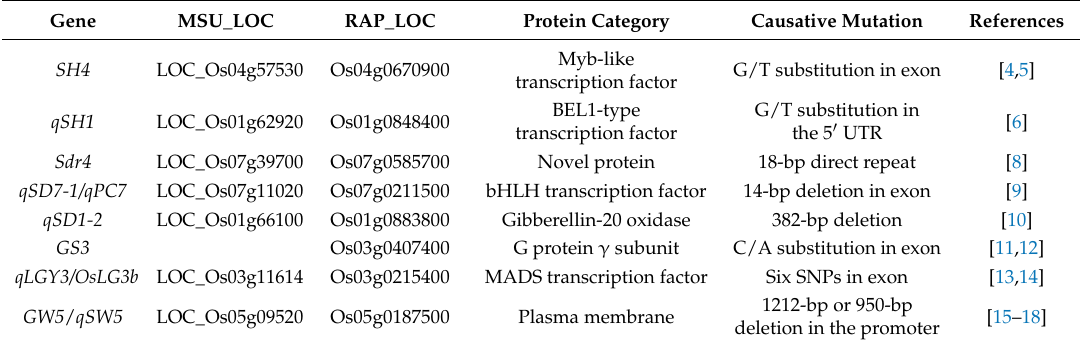
Table 1. Reported genes of domestication traits including seed shattering, seed dormancy, and grain size. Gene MSU_LOC RAP_LOC Protein Category Causative